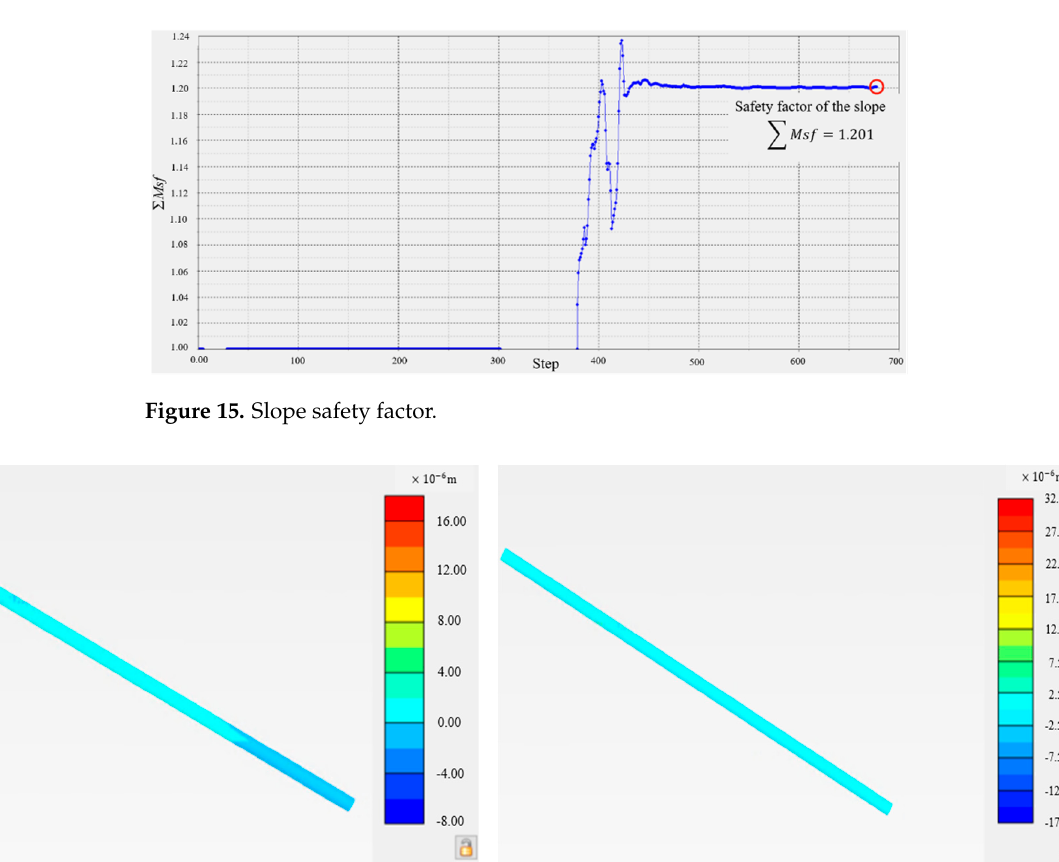
displacement of east exhaust inclined shaft.